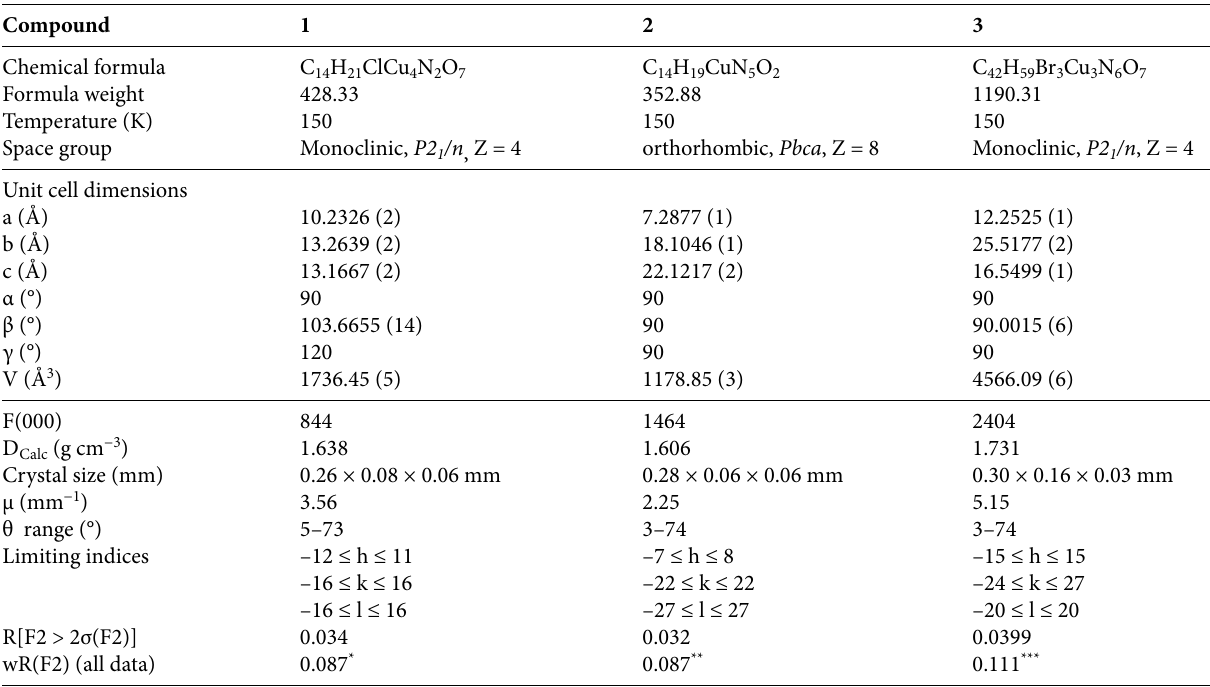
Table 1. Crystallographic data of the complexes 1 –